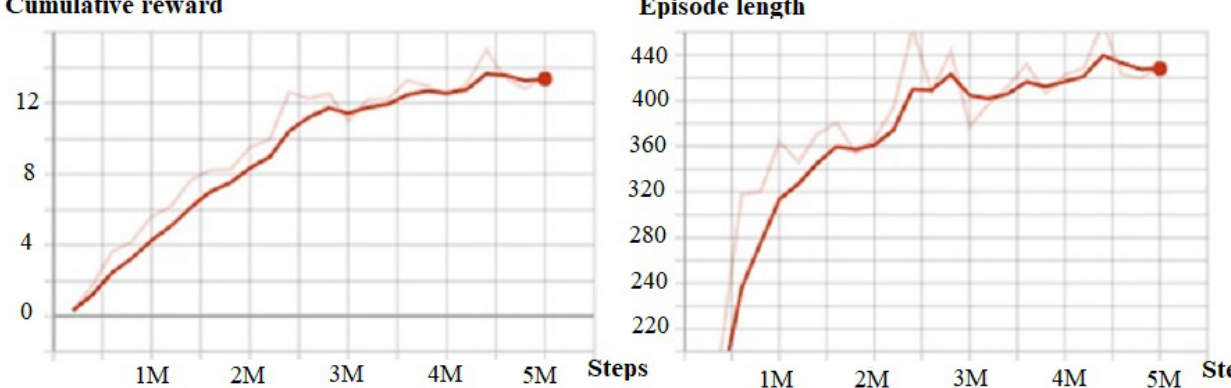
Figure 4. Learning progress during training in the fourth